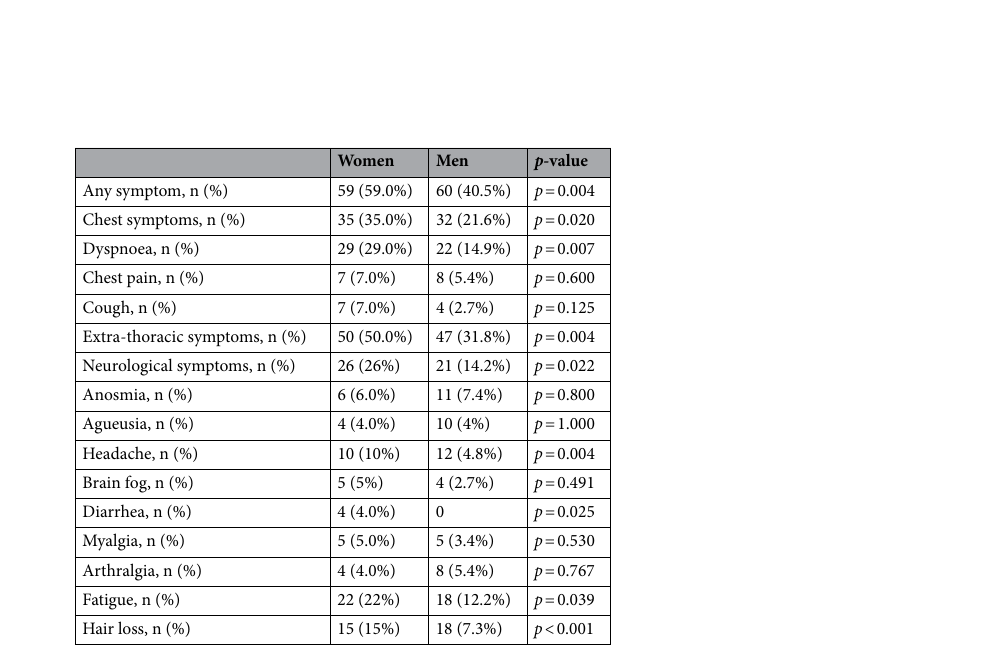
Table 3. Prevalence of persisting symptoms at 6 months based on